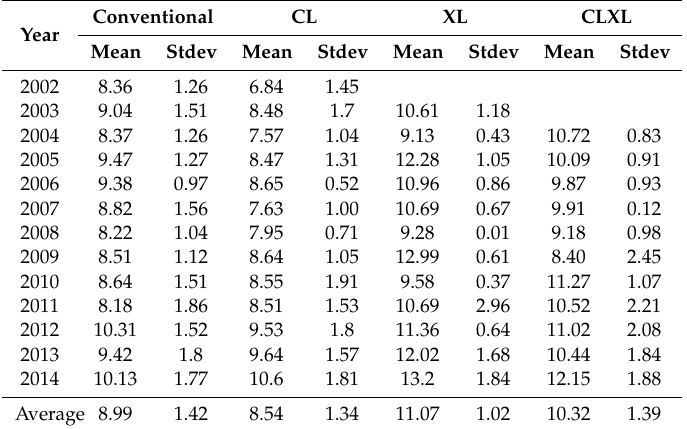
Average yield (metric ton ha − 1 ) for Conventional, Clearfield ® (CL), hybrid (XL), and Clearfield ® hybrid (CLXL) rice in the U.S. Mid-South: 2002–2014.